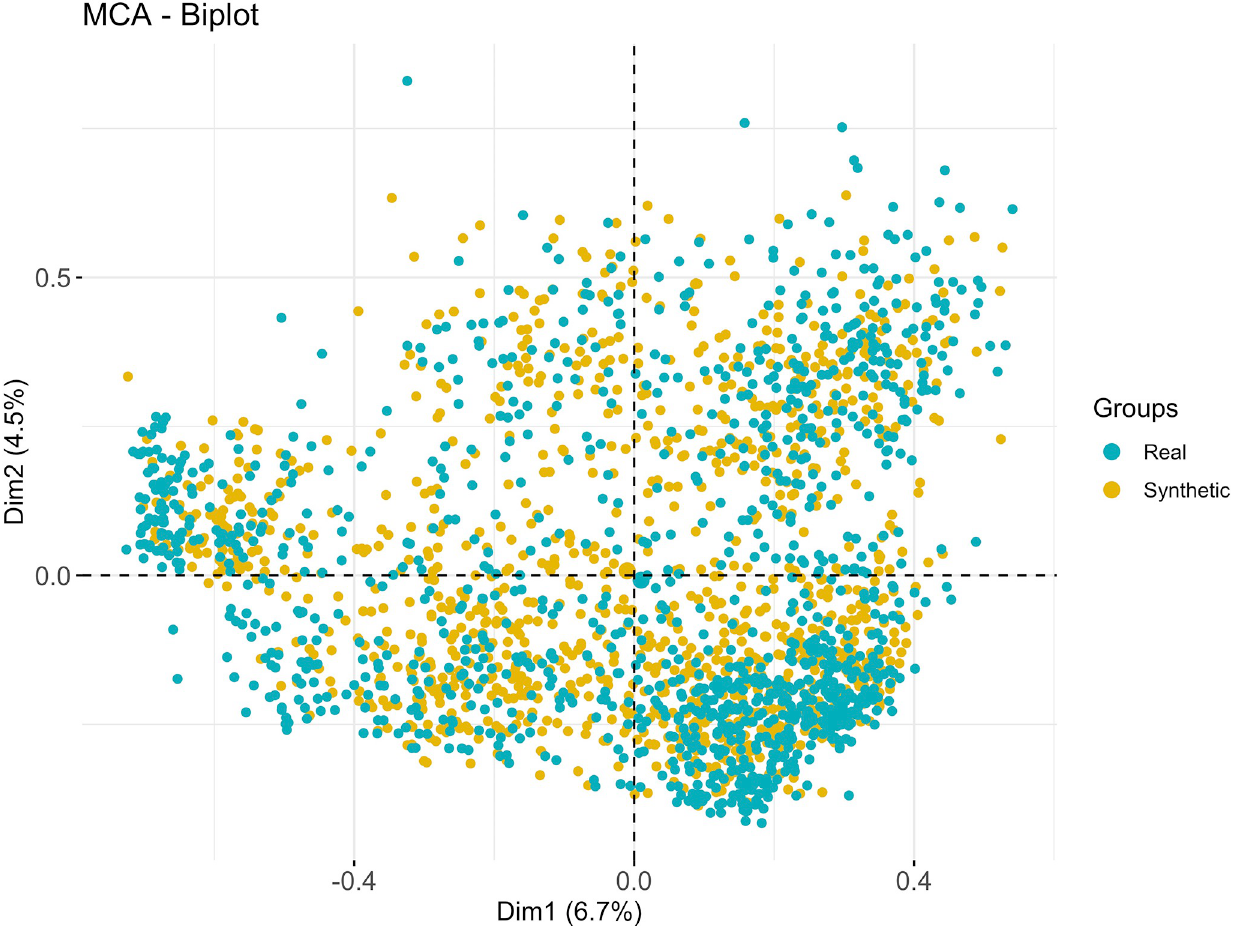
Fig 2. Multiple correspondence (MCA) analysis plot of prospective data of real (in blue) and simulated (in yellow) TREND